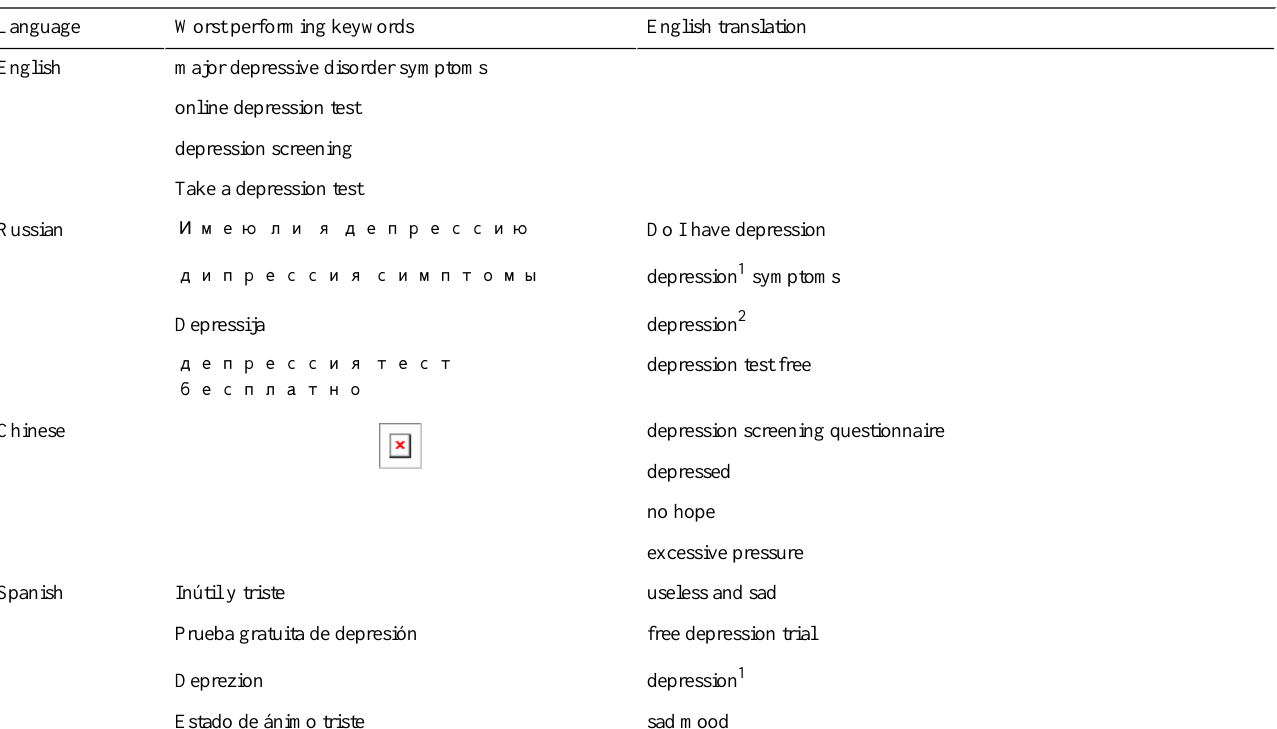
Table 3. Worst performing keywords.